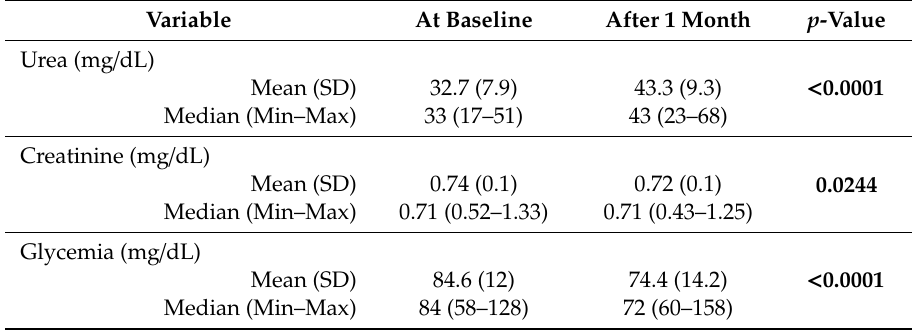
Table 3. Changes of plasma parameters after four weeks of dietary intervention with OFI-supplemented pasta in all patients. In bold, the p -values that reached statistical